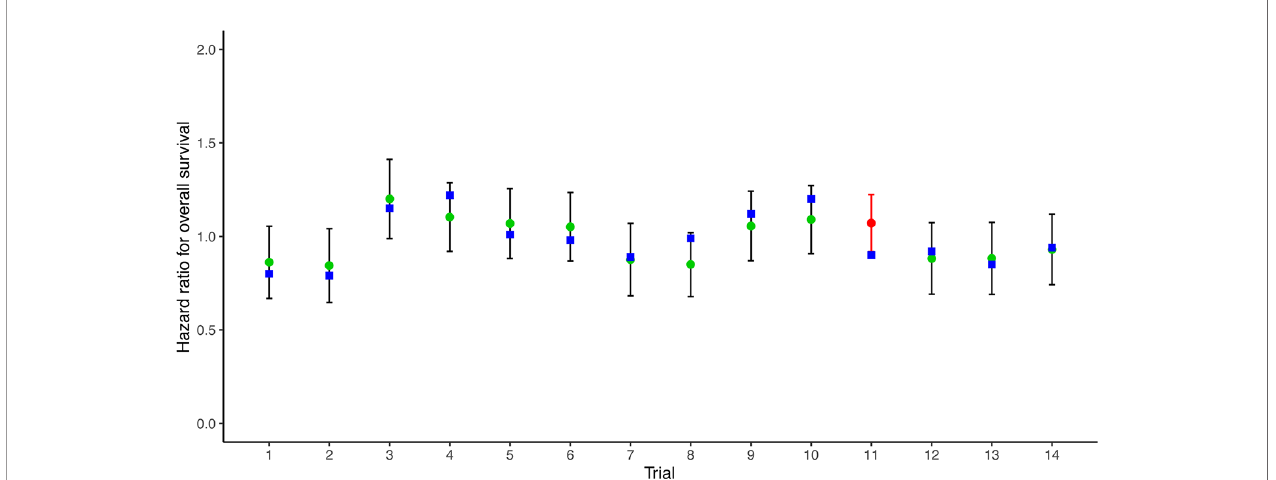
FIGURE 2 | Leave-one-out cross-validation analysis of the prediction of HR for OS based on HR for PFS/TTP. Green circles represent predicted hazard ratio for OS, vertical lines for 95% prediction intervals, and blue squares for observed hazard ratios for OS. Red circles and lines indicate that the observed HR is beyond the 95% prediction intervals. HR, hazard ratio; OS, overall survival; PFS/TTP, progression-free survival/time to